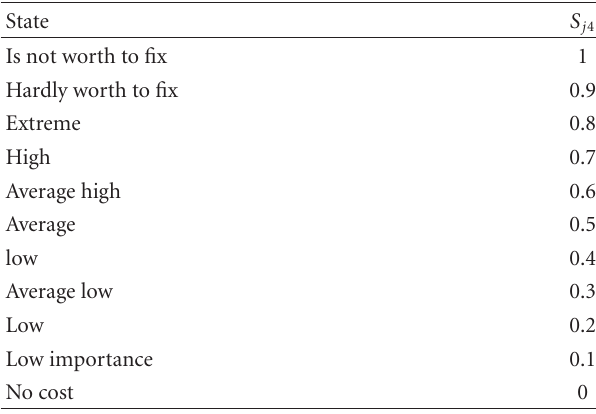
Table 7: Classification of repairing costs of failure modes.